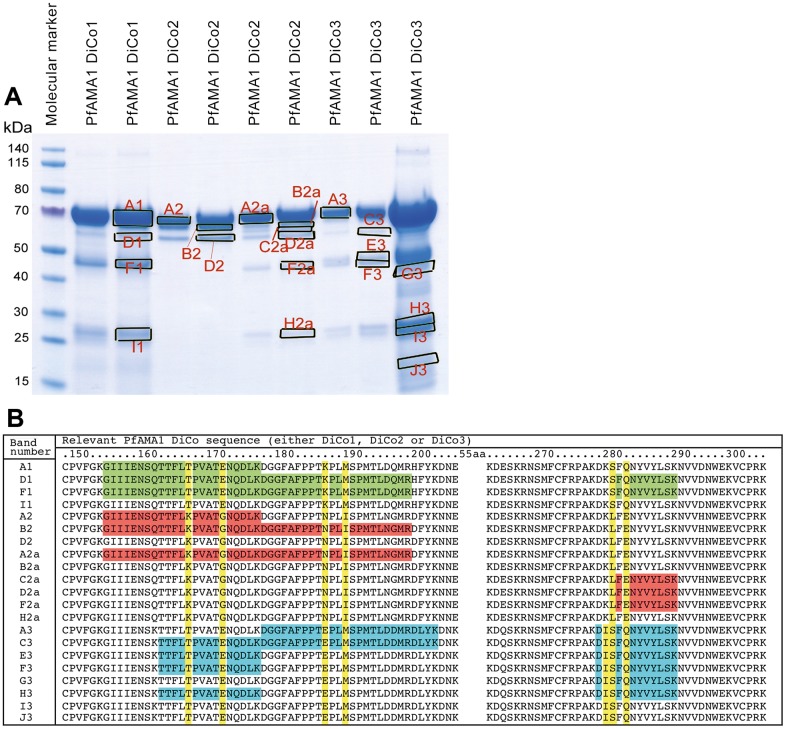
Signature peptide MS analysis of pre-GMP produced PfAMA1 DiCo Drug substance intermediates.Panel A. Overloaded SDS-Gel of HIC eluate fractions with excised bands in marked boxes. Panel B. Examples of signature peptides identified in the 21 excised protein bands for PfAMA1-DiCo preparations. Key to preparations: PfAMA1 DiCo1 (Green), PfAMA1 DiCo2 (Orange) and PfAMA1 DiCo3 (Blue). In yellow the signature amino acids in these peptides, allowing for the differentiation between individual PfAMA1 DiCo proteins. Numbering of the amino acids is as in [15].